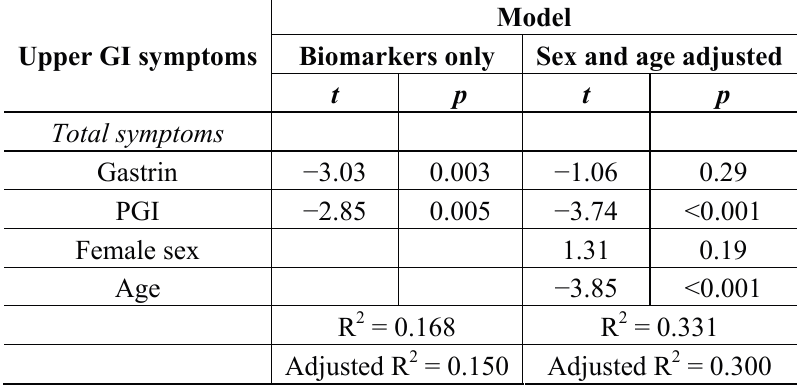
Table 5. Associations between upper GI symptoms and biomarkers: Multiple regression